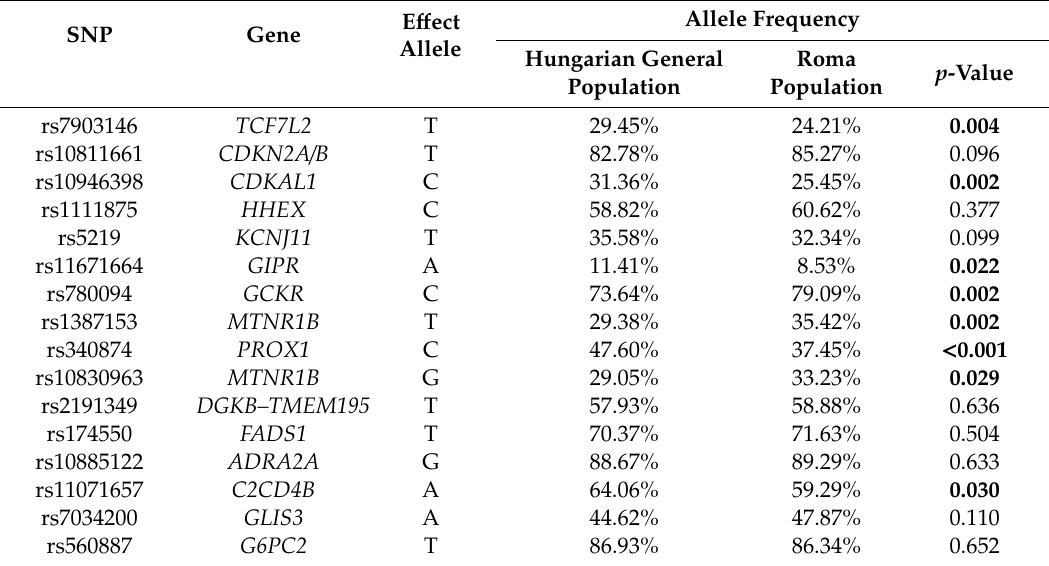
Table 4. Comparison of susceptible allele frequencies between study populations.